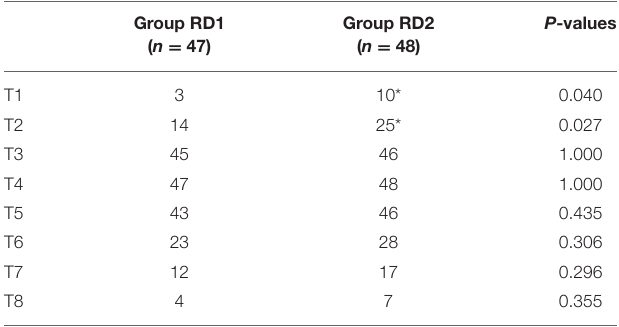
TABLE 3 | Dermatomal effects after SABP between the two groups.